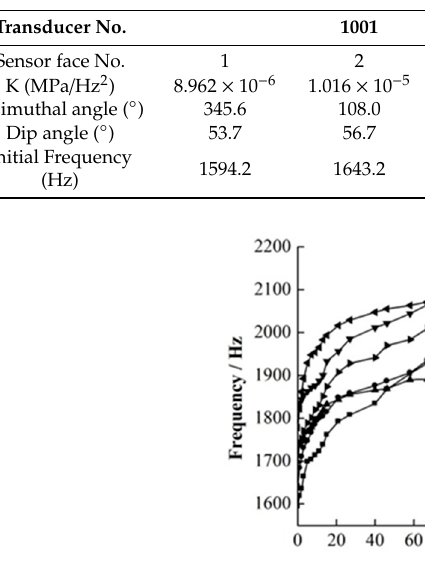
Table 3. Information for transducers embedded in PDS No. 1 coal mine.